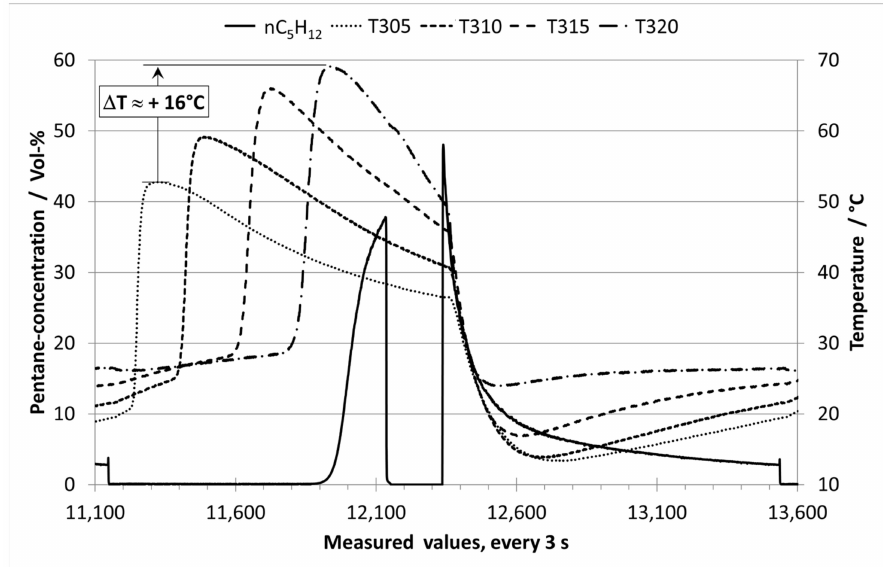
Figure 9. Concentration and temperature profile in the filter for E10/humid N 2 in 250th cycle.